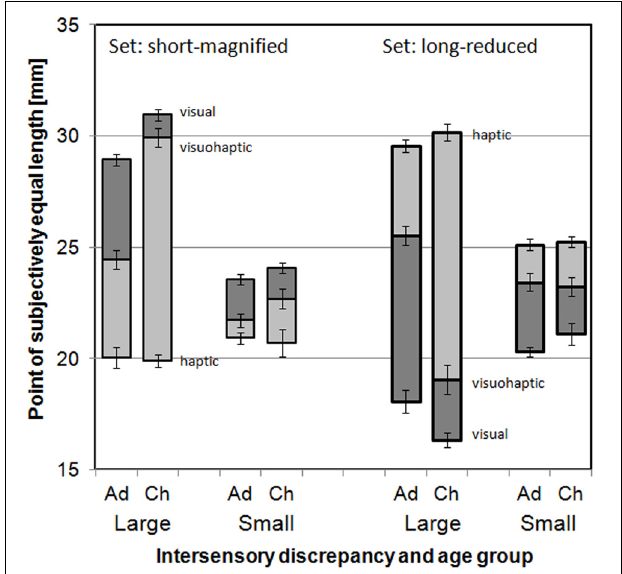
FIGURE 1 | PSEs as a function of Intersensory discrepancy, Age group (Ad[ults] vs. Ch[ildren]), and Stimulus Set. The light gray end of the bars (lower end on the left , upper end on the right ) refers to the haptics alone standard, the dark gray end to the vision alone standard and the border between light and dark gray to the visuo-haptic standard. Error bars indicate standard